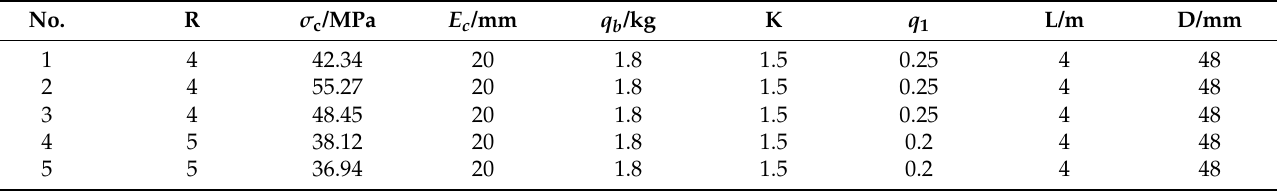
Table 5. SWB involved fixed parameters in practical engineering.